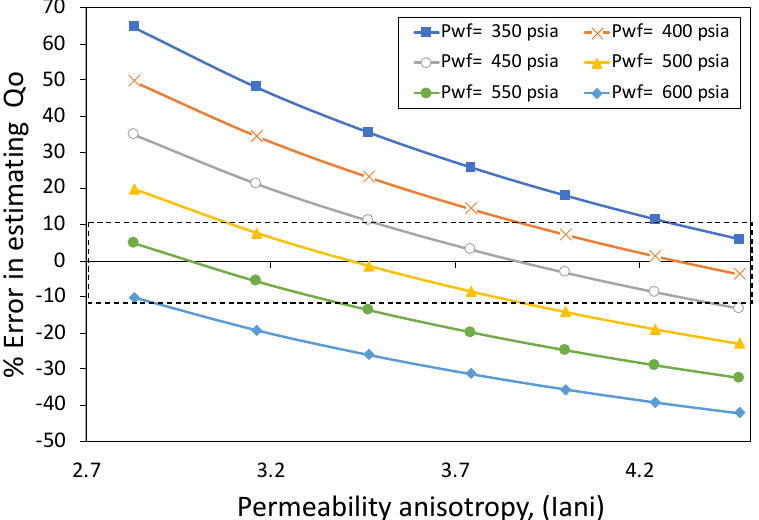
Figure 8. Errors in estimated well production rate; the coupled e ff ect of uncertainties in bottom-hole pressure and permeability anisotropy (Well #1).